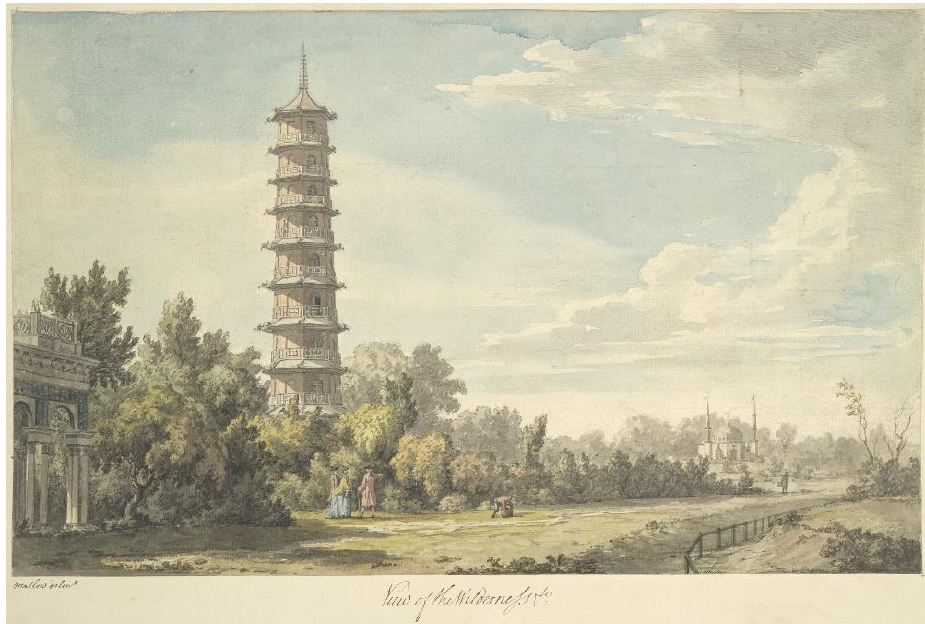
Figure 3. A view of the Great Pagoda at Kew Gardens in 1763 (Metropolitan Museum of Art, CC0 1.0, via Wikimedia Commons, https://en.wikipedia.org/wiki/Great_Pagoda,_Kew_Gardens#/media/File:View_of_the_Wilderness_at_Kew_MET_DP105027.jpg, accessed on 5 May 2022).